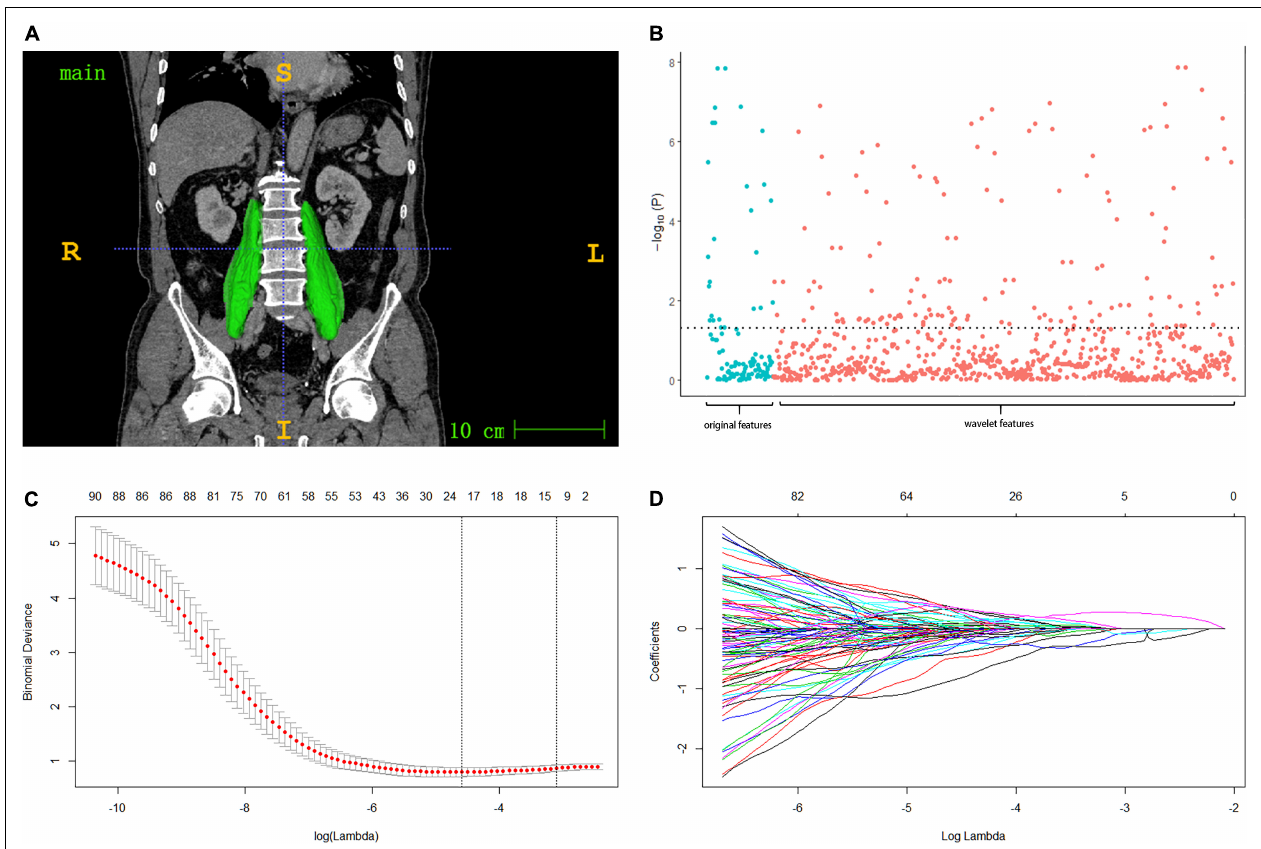
FIGURE 1 | (A) Muscle ROI: after the muscle region is labeled in ITK-SNAP software, semi-automatic drawing is adopted to check the psoas major muscle region and 3d reconstruction. (B) Manhattan plot presenting the strength of association –log10 ( p -value) of spearman’s rho between the psoas radiomic features and the original sarcopenia (diagnosed by SMI, grip strength and walking speed). (C,D) Model with smallest lambda was selected lambda 0.0451, ln (lambda) –3.098, and 14 features selected from the lasso were included in the subsequent radiomic score